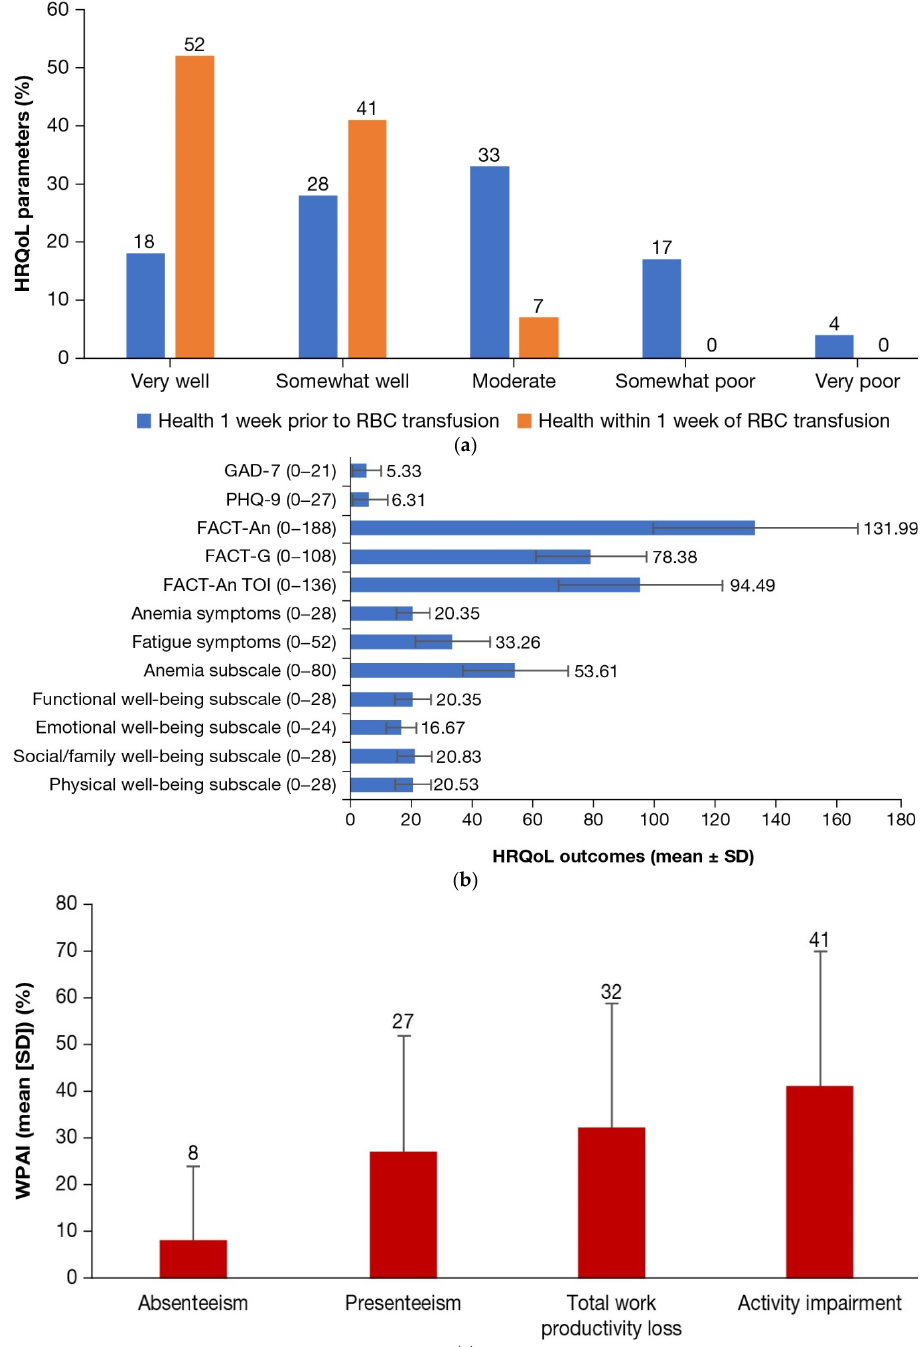
Figure 1. Health-related quality of life outcomes. ( a ) Health status 1 week prior and within 1 week of RBC transfusion; ( b ) HRQoL outcomes (mean FACT-An, PHQ-9, GAD-7 domains) (for subscales and FACT scales, higher scores imply better outcomes; for PHQ-9 and GAD-7, higher scores imply worse outcomes); ( c ) WPAI outcomes. Three individuals indicated that they are employed; however, they had not worked in the past 7 days. One of those individuals missed 40 h of work in the past week due to β -thalassemia. FACT: Functional Assessment of Cancer Therapy; FACT-An: FACT-Anemia; FACT-G: FACT-General; GAD-7: Generalized Anxiety Disorder-7; HRQoL: health-related quality of life; PHQ-9: Patient Health Questionnaire-9; RBC: red blood cell; SD: standard deviation; TOI: Trial Outcomes Index; WPAI: Work Productivity and Activity